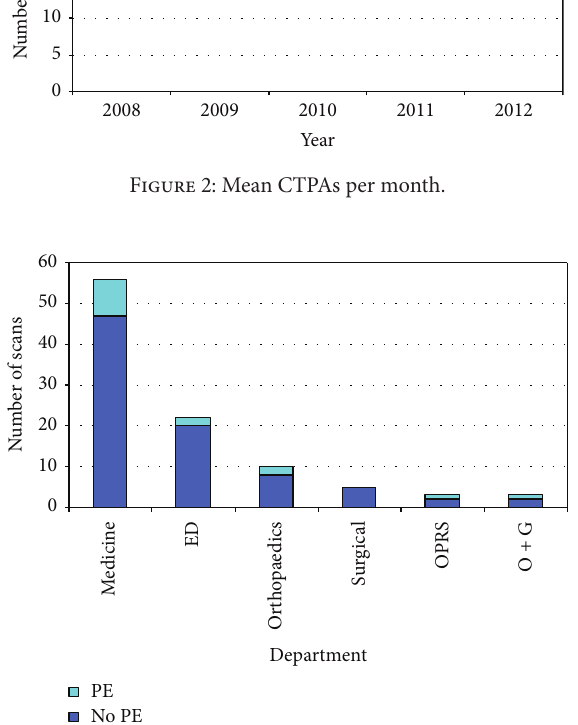
Figure 3: Results of scans by department.